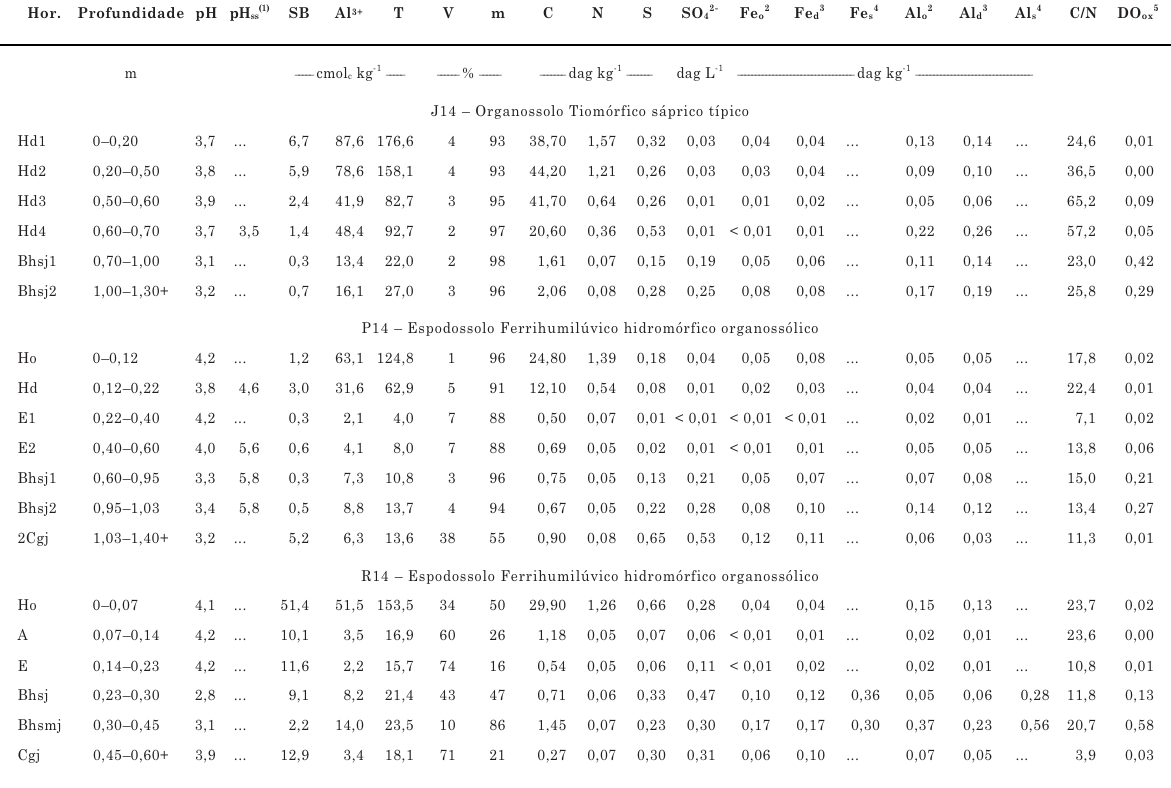
horizonte A horizonte H horizonte E horizonte Bhs